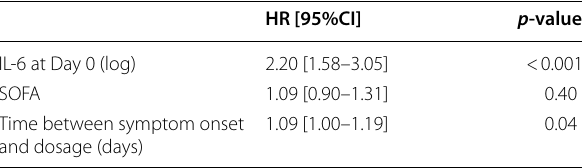
Table 2 Analysis of predictors for mortality using multivariable Logistic Regression